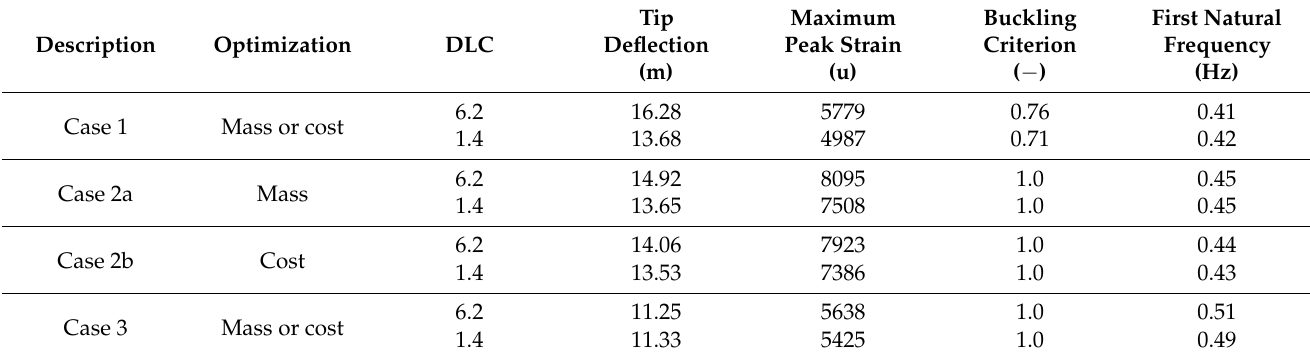
Table 7. Summary of design constraints after